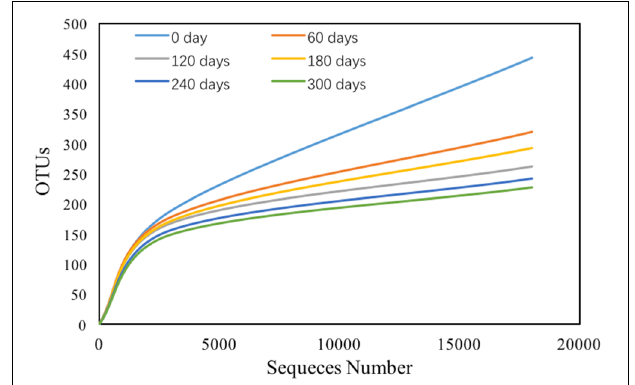
FIGURE 4 | Rarefaction curves of six